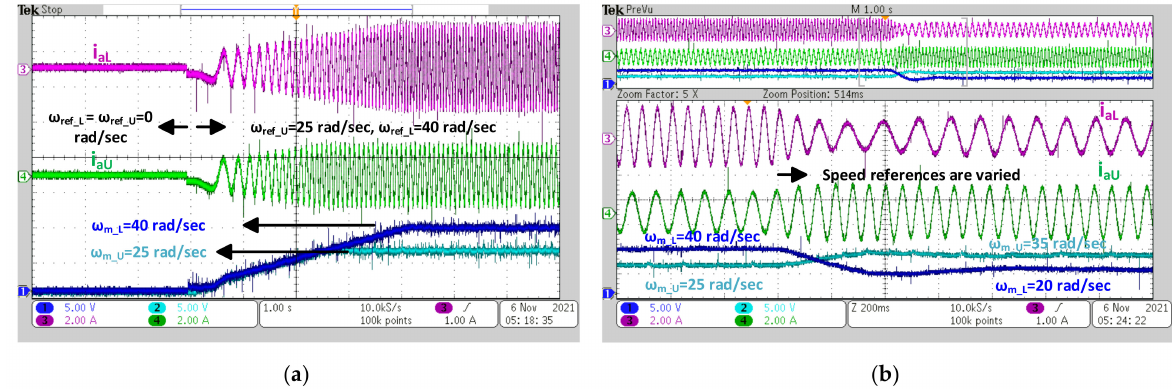
Figure 9. Experimental waveforms for speeds ( ω m_U and ω m_L ) and one-phase stator current ( i aU and i aL ) for each machine. Scope channel 1: Upper machine speed, ω m_L . Scope channel 2: Lower machine speed, ω m_U . Scope channel 3: Lower machine stator current, i aL . Scope channel 4: Upper